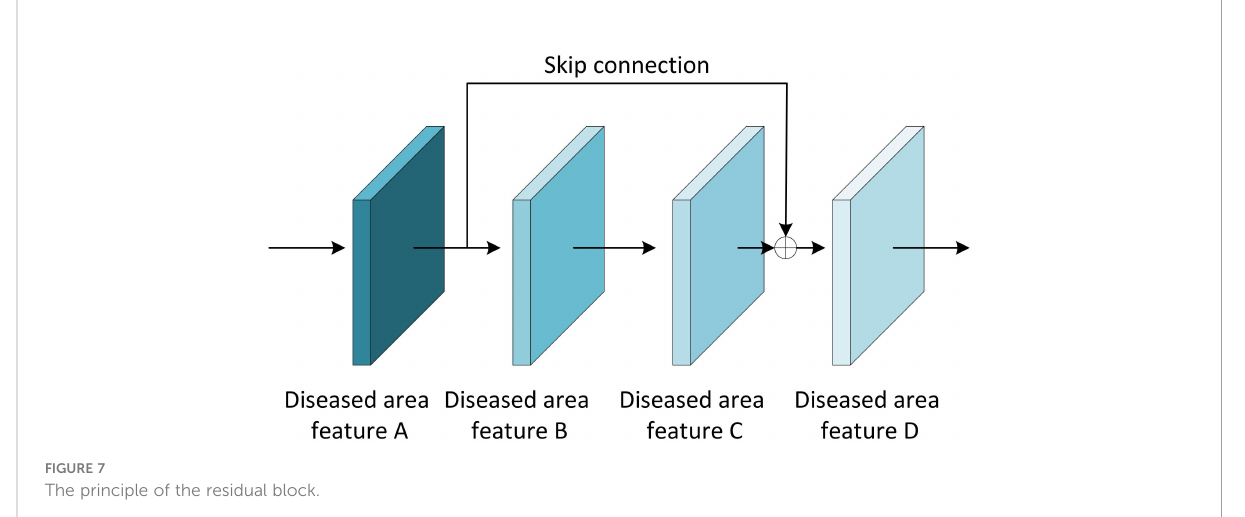
FIGURE 7 The principle of the residual